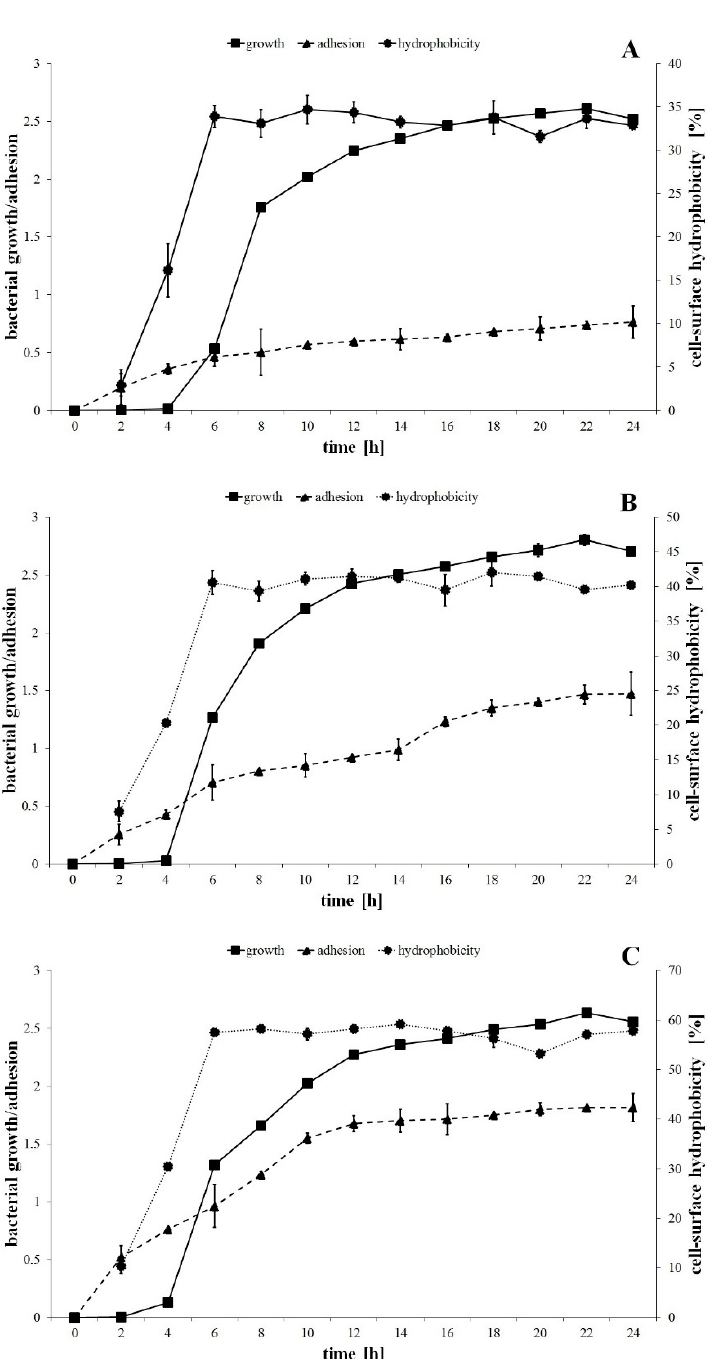
Figure 1. The bacterial growth, adhesion to the catheter and cell-surface hydrophobic properties of the P. mirabilis ATCC 29906 ( A ), 1984 ( B ) and C12 ( C ) strains. The studied strains were differentiated in terms of cell hydrophobic properties. The cell-surface hydrophobicity values were equal to 3%, 7.5% and 10.3% for 2 h cells of the P. mirabilis ATCC 29906, 1984 and C12 strains, respectively (Figure 1). During the exponen- tial growth phase, the percentage of cell hydrophobicity increased respectively to 33.9%, 40.6% and 57.5%, while during the stationary growth phase it remained unchanged. The Fisher ′ s test showed significant differences ( p ≤ 0.05) between the P. mirabilis ATCC 29906 and the C12 strains (Figure 1A,C), pointing to the first as the most hydrophilic and to the second as the most hydrophobic.